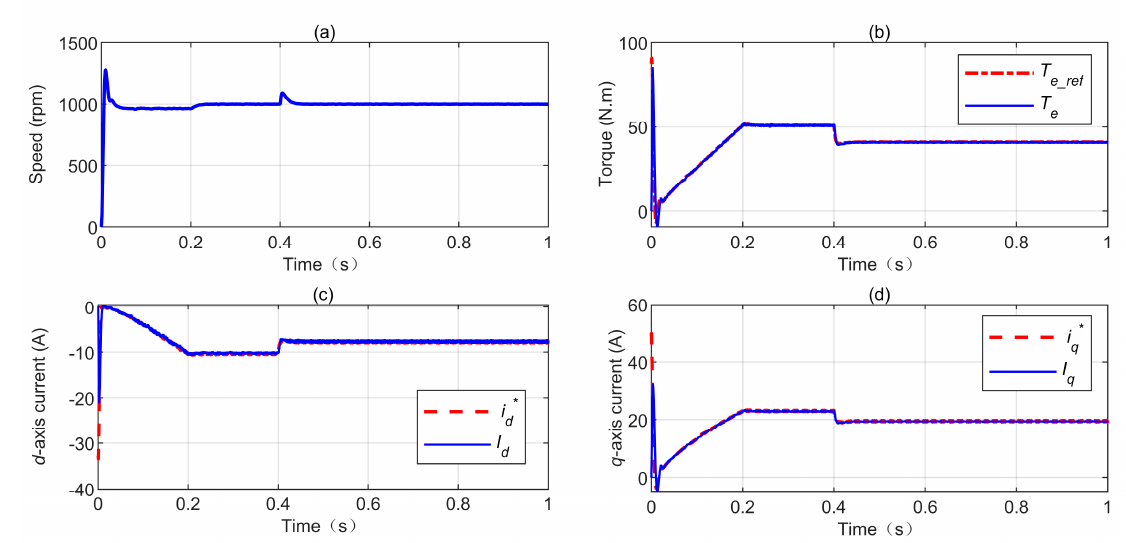
Figure 3. The simulation results: ( a ) machine speed; ( b ) reference and machine torque; ( c ) d-axis